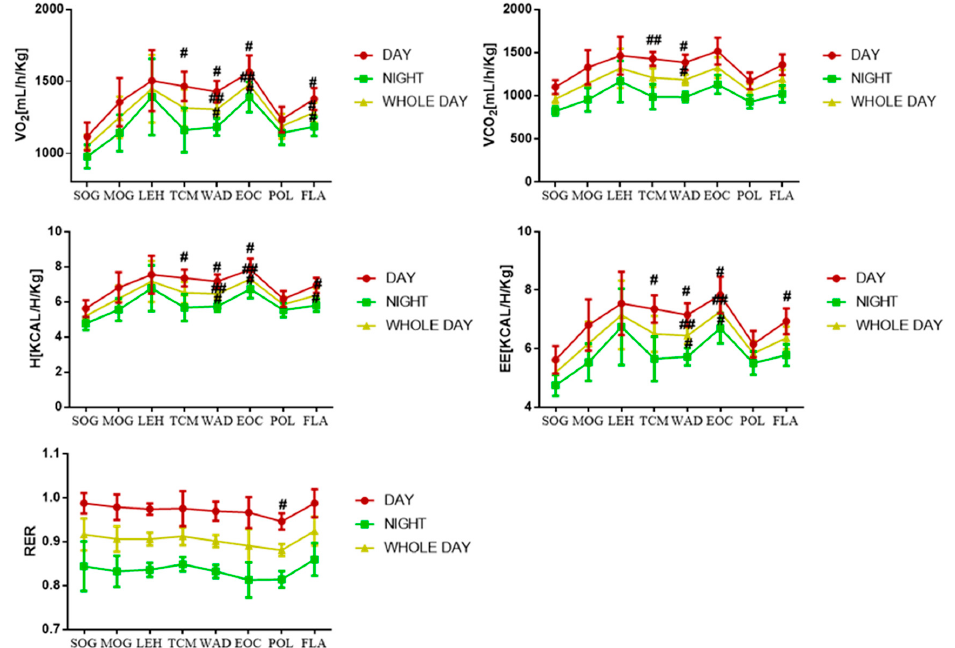
Figure 3. Changes of VO 2 , VCO 2 , H, EE and RER in rats during the day, night and the whole day. Notes: # p < 0.05, ## p < 0.01 compared with SOG. Sham-operated group (SOG), Chronic nonbacterial prostatitis model group (MOG), Water decoction treatment group (WAD), Essential oil treatment group (EOC), Polysaccharide treatment group (POL), Flavonoids treatment group (FLA), Pule’an tablet treatment group (TCM), Levofloxacin treatment group (LEH), O 2 consumption (VO 2 ), CO 2 production (VCO 2 ), Heat production (H), Energy expenditure (EE), Respiratory exchange ratio